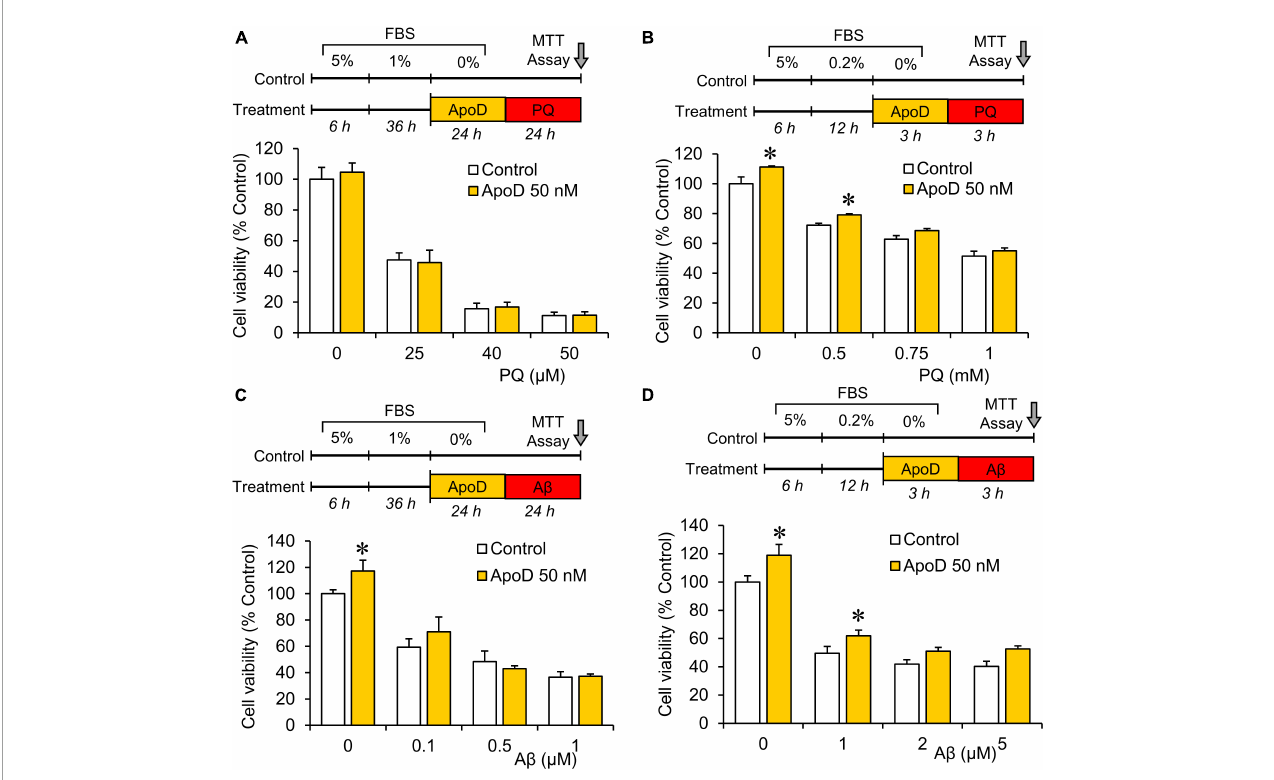
FIGURE3 Pre-exposure to purified human ApoD does not rescue BV2 microglial cells from PQ or A β -induced cell death. Cell viability analysis of BV2 cells by MTT assay upon PQ (A,B) or A β (C,D) oligomers exposure with or without pre-exposure to ApoD. Treatment started after adaptation of cells to serum starvation (5 - 1 - 0% for 24 h experiments; 5 - 0.2 - 0% for 3 h experiments). Addition of ApoD (50 nM) to the culture medium exerts a mild pro-survival effect on BV2 cells in control conditions but is not sustained with increasing doses of PQ or A β . All experiments were performed in triplicates. Asterisks point to significant differences in comparison with control conditions evaluated by ANOVA followed by Holm-Sidak pairwise